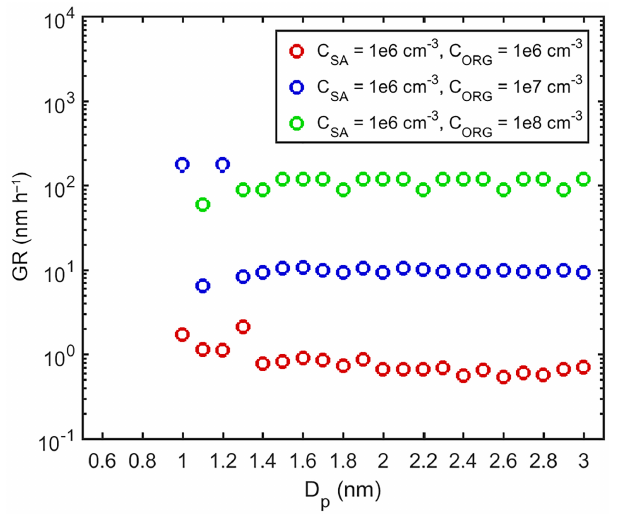
Figure 7. GRs determined for different size bins in simulations with SA–DMA and ELVOC. The colors indicate vapor concentrations in each